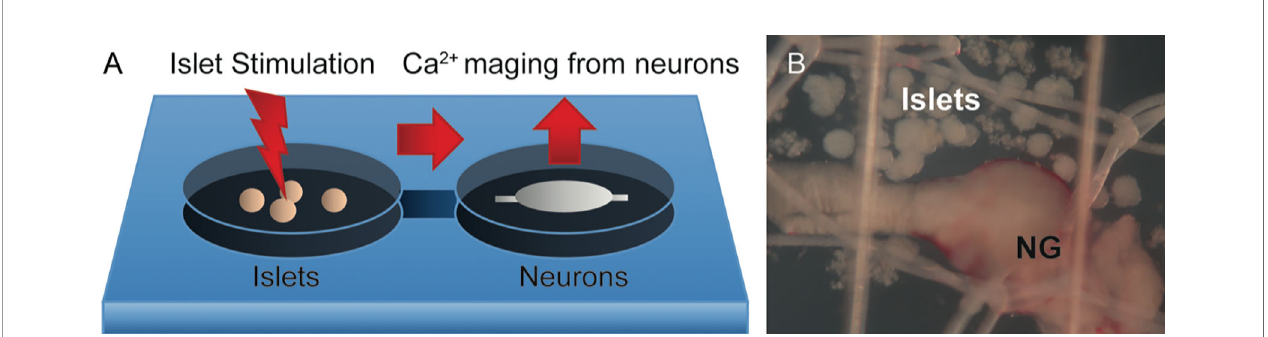
FIGURE 7 | Potential model for recording Ca 2+ neuronal activity in response to islet stimulation in vitro . (A) Schematic representation of the proposed experimental setup, where islets are placed upstream of neurons in a perfusion chamber or a micro fl uidics device. Pharmacological or optogenetic stimulation of islets will induce release of substances that have a potential to act on downstream neurons. (B) Representative photomicrograph of islets placed in close proximity to the nodose ganglion (NG) in an imaging